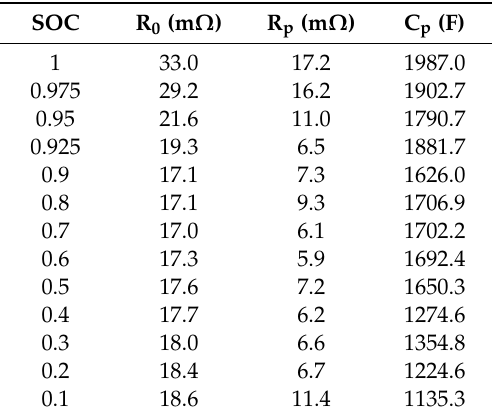
Table 1. Thevenin model identification